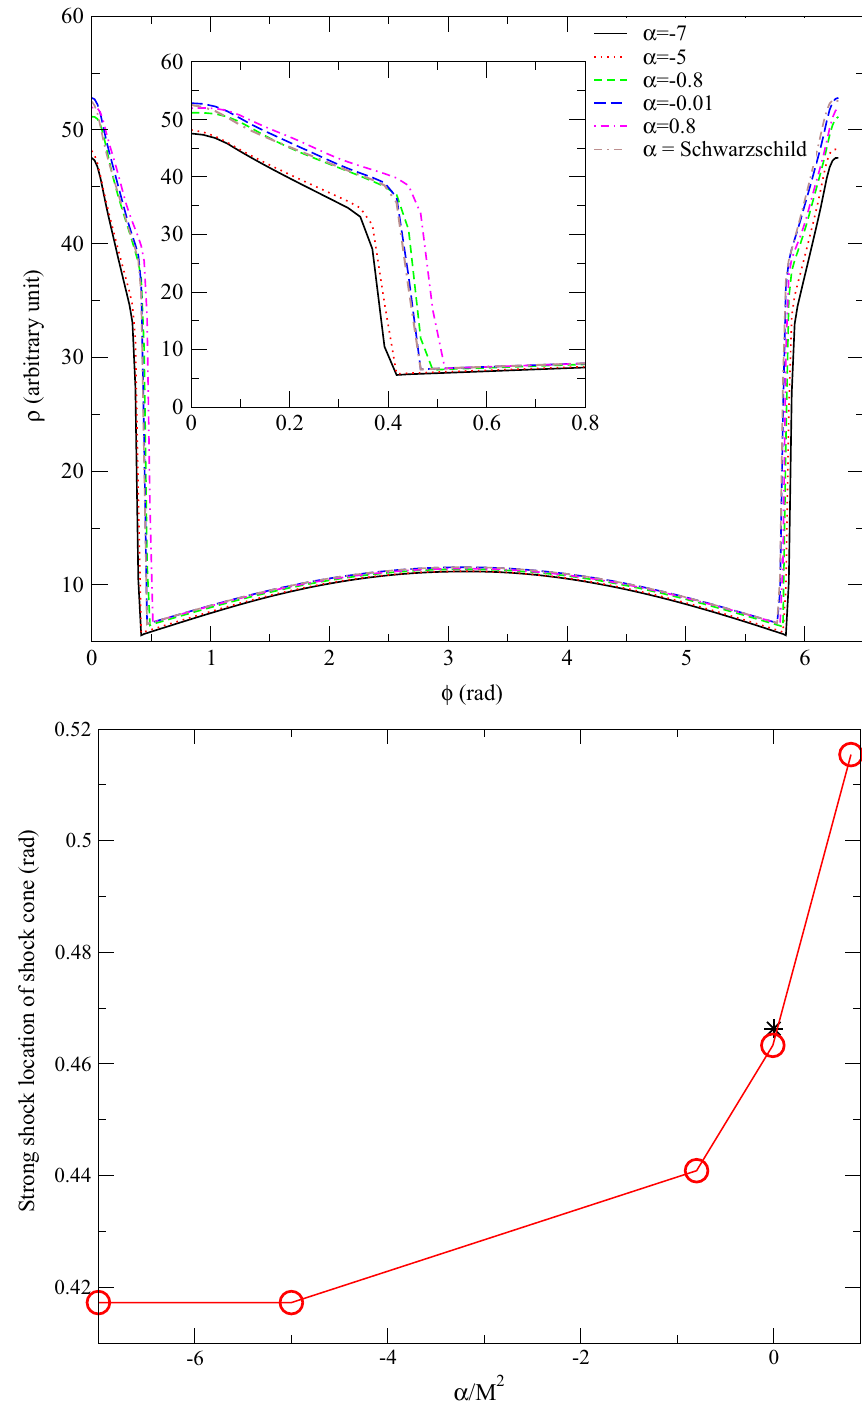
Fig. 6 Left panel The rest-mass density as a function of the angular coordinate φ at r = 6 . 5 M for the varying values of the Gauss–Bonnet coupling constant α and Schwarzschild black hole. The embedded plots indicates the left shock locations to see the differences for varying α . Right panel The variation of the opening angle of the shock cone versus α computed at φ =∼ 0 . 5 rad in left panel. The black star represents the location for the Schwarzschild black